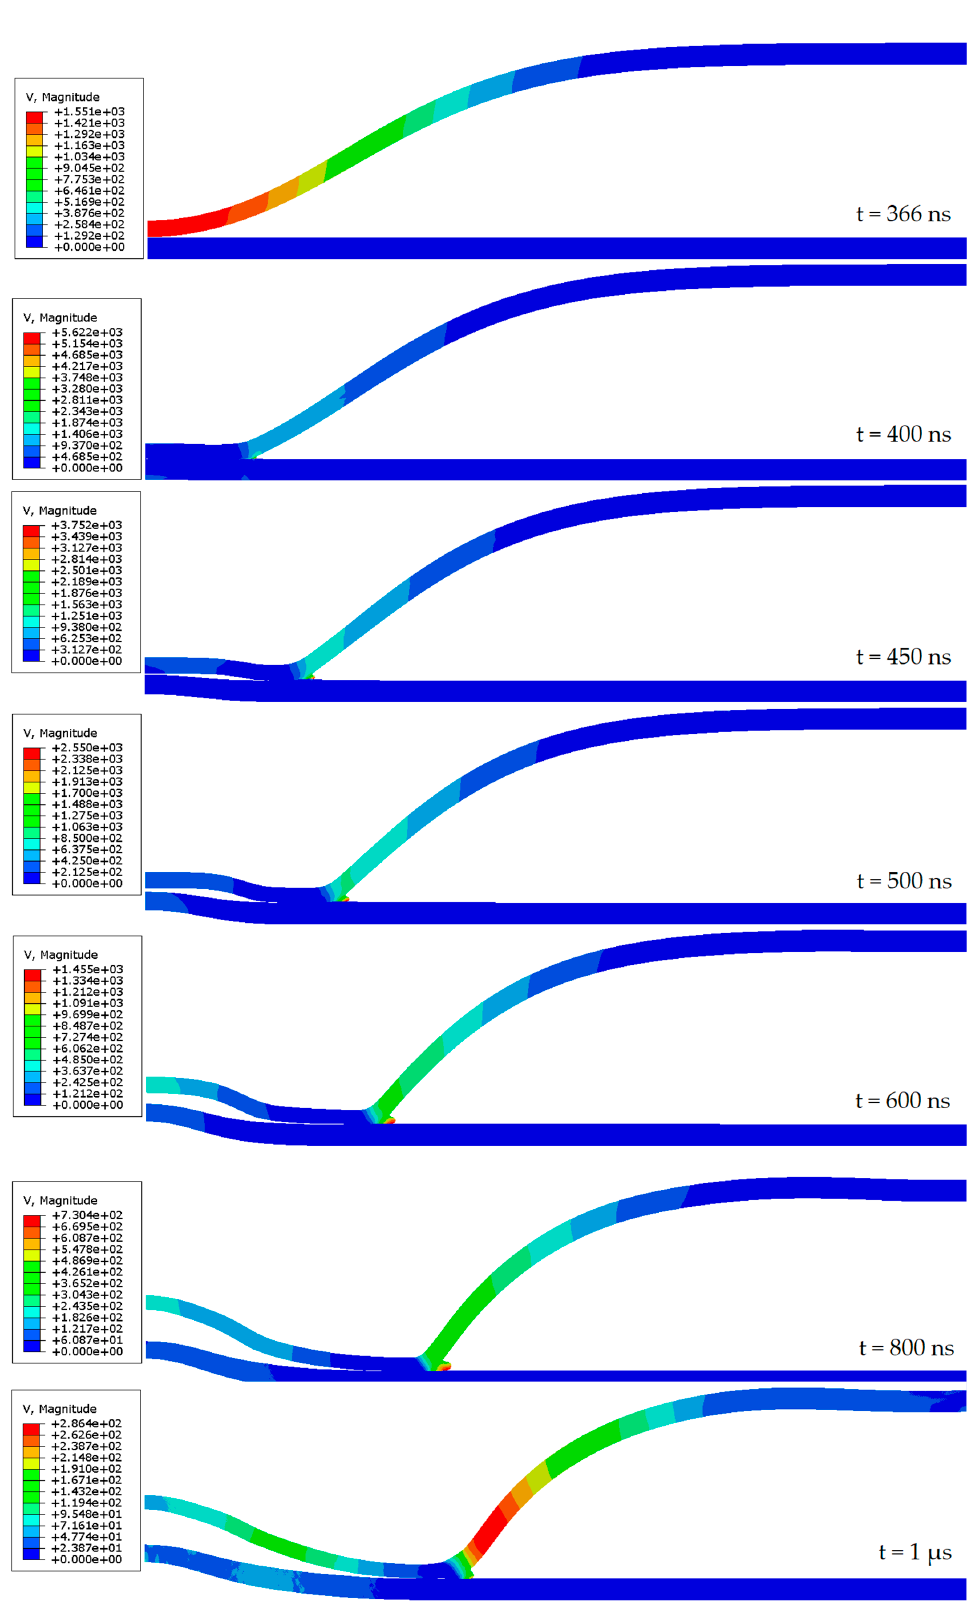
Figure 14. Axisymmetric simulation results: von Mises stress (Pa) contour plot and deformed shape at different times during the collision.